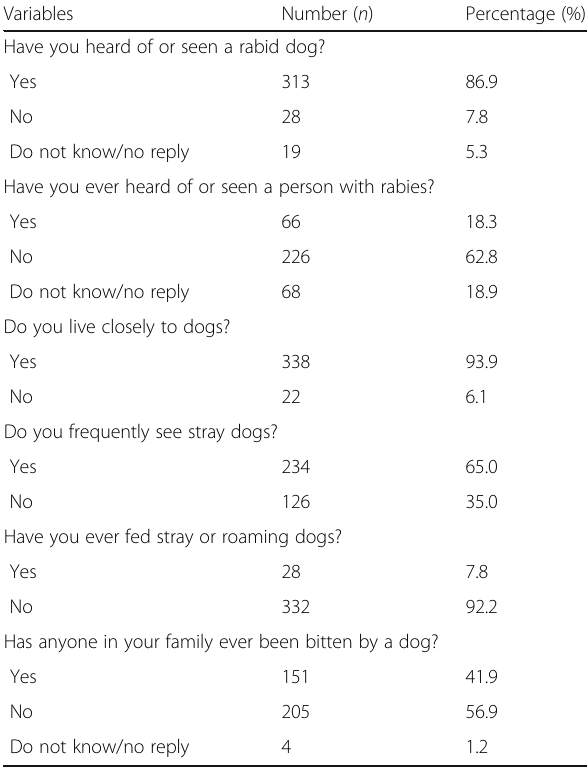
Table 4 Respondents ’ experience related to rabies and dogs (